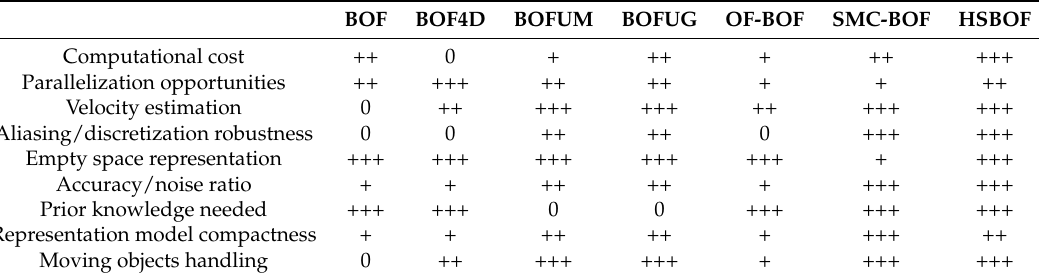
Table 1. Key performance